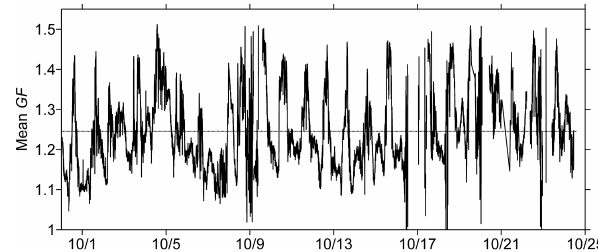
Figure 5. Time series of the volume-weighted mean particle diam- eter growth factor (GF) derived from HTDMA measurements (date format: month/day, 2015). The black dashed line stands for the tem- poral mean GF averaged over the entire observation period. Table 3. Derived mean κ values of organics with consideration of 10.0% EC mass fraction in total NR-PM 1 , as well as the mean κ results for HTDMA measurements conducted within the overlapped ToF-ACSM observation period of 10–24 October 2015 (i.e., κ HTDMA ). Mean κ (mean ±